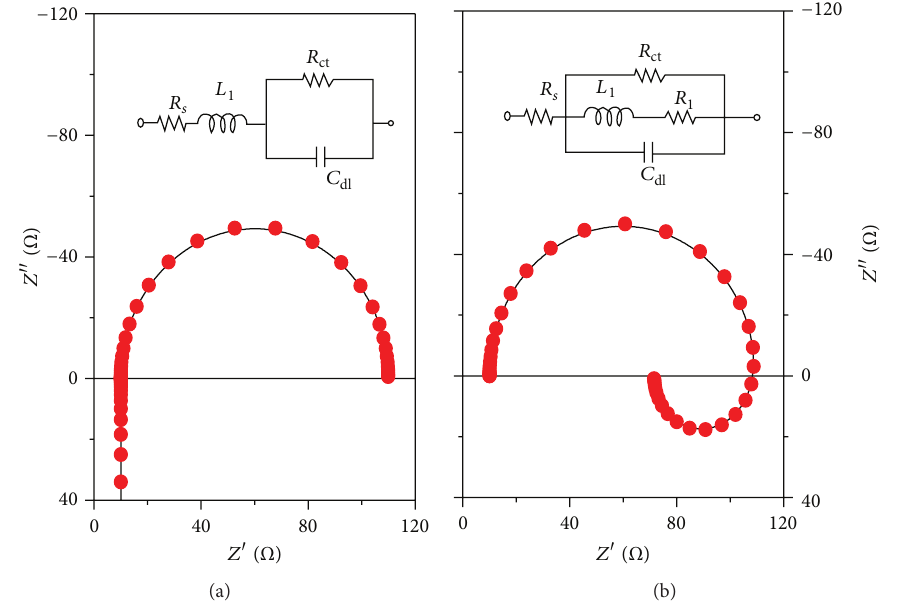
= 100 Ω , 𝑅 = 160 Ω , 𝐶 = 100 𝜇 F, and 𝐿 = 10 𝜇 H for (a) and 100 H 1 1 ct dl